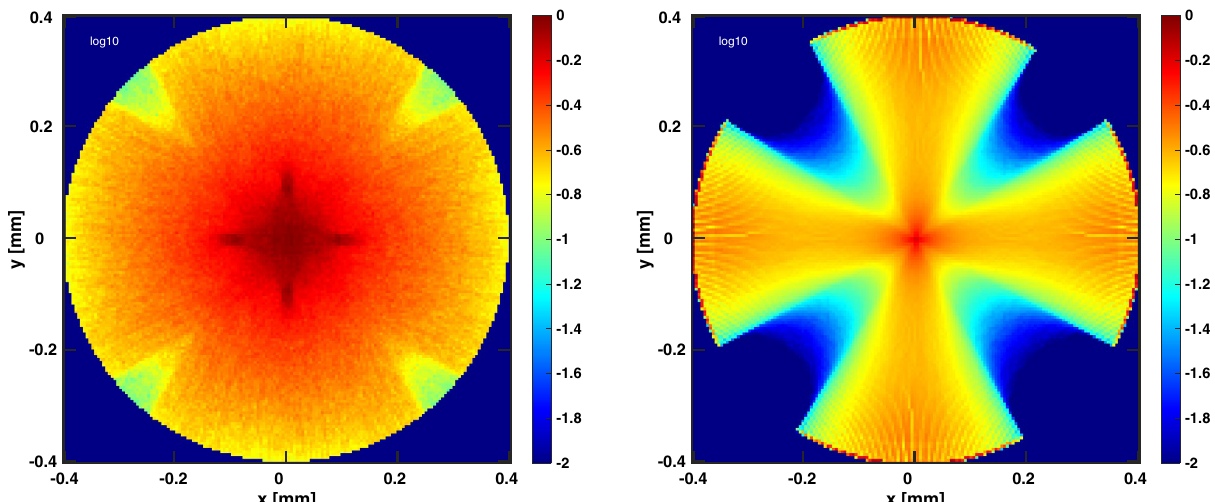
Figure 7. Cross-sectional view of normalized photon energy deposition in a 0.8 mm diameter nerve-analog from mcxyz (left) and the MC model presented (right). Four light sources are used in each simulation (one light source placed at each cardinal